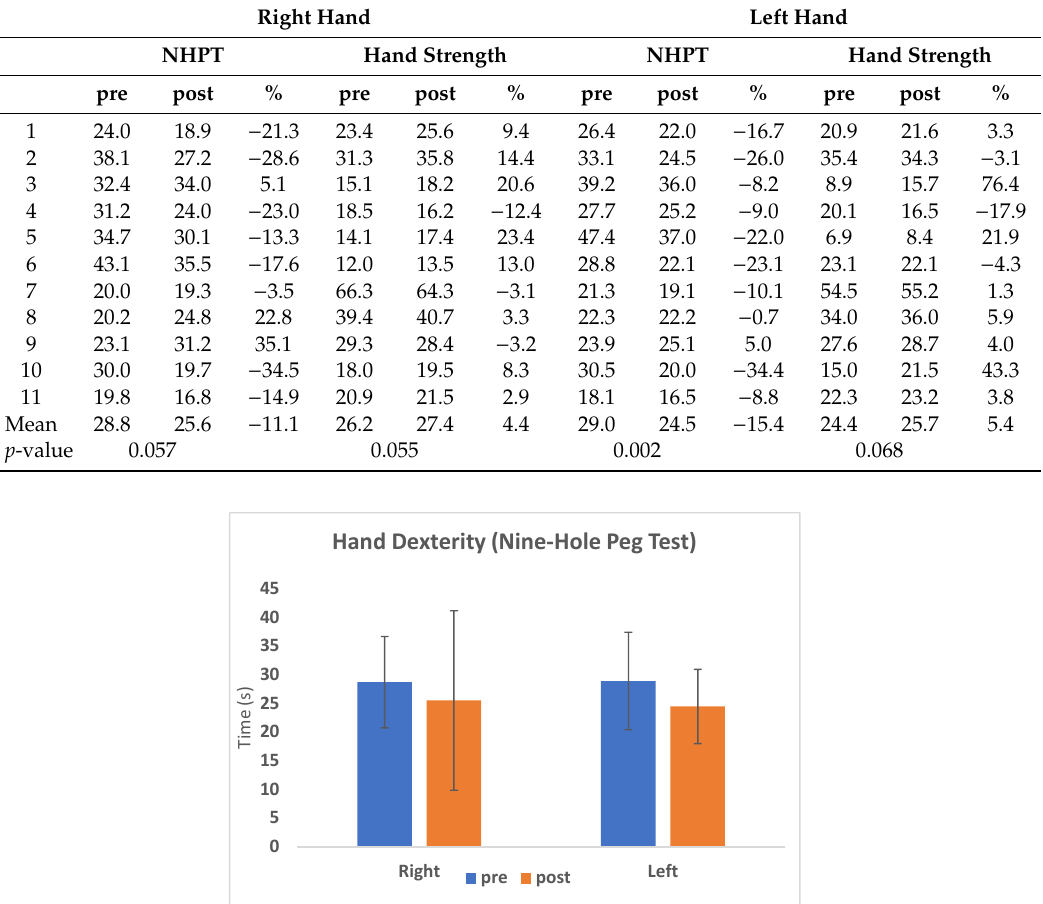
Table 4. Measurement of dexterity and hand strength. The percentage of improvements for NHPT and hand strength was reported in green.